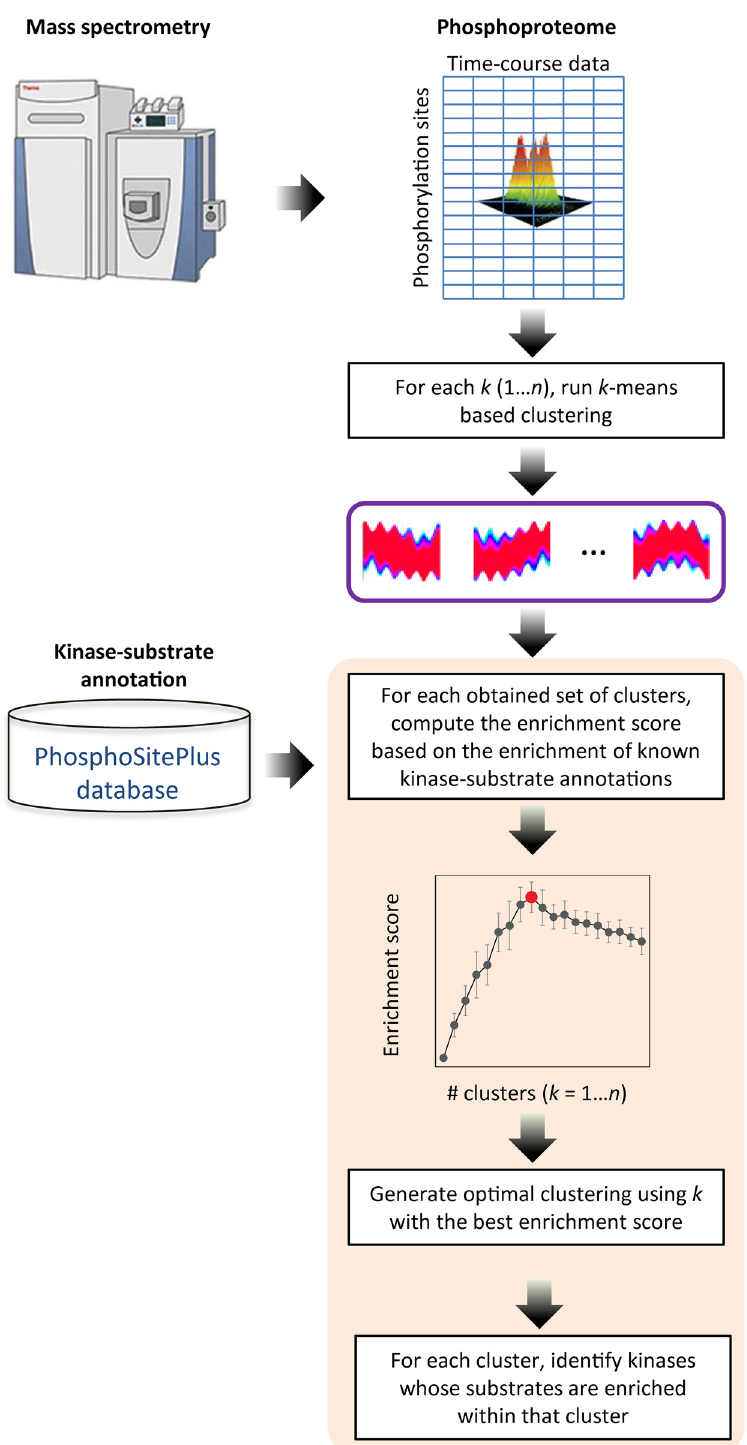
Fig 1. Schematic overview of CLUE. The level of phosphorylation for each phosphorylation sites in the proteome are quantified in time-course by mass spectrometry. First, time-course profiles of phosphorylation sites are partitioned into clusters using a k -means clustering-based algorithm for a range of values for k . Next, the clustering result, for each k , is evaluated based on the correct clustering of known substrates of kinases, as annotated in the PhosphoSitePlus database [53], and an enrichment score is computed. The